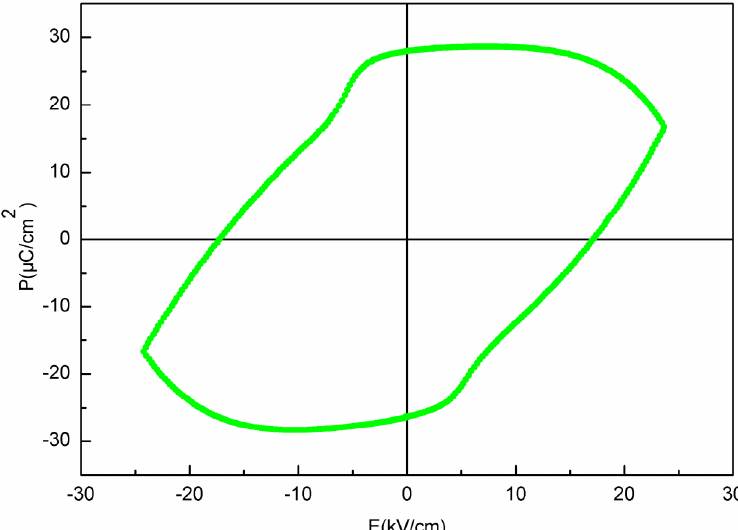
Figure 4. P – E hysteresis loops of KNN-LT single crystals at 20